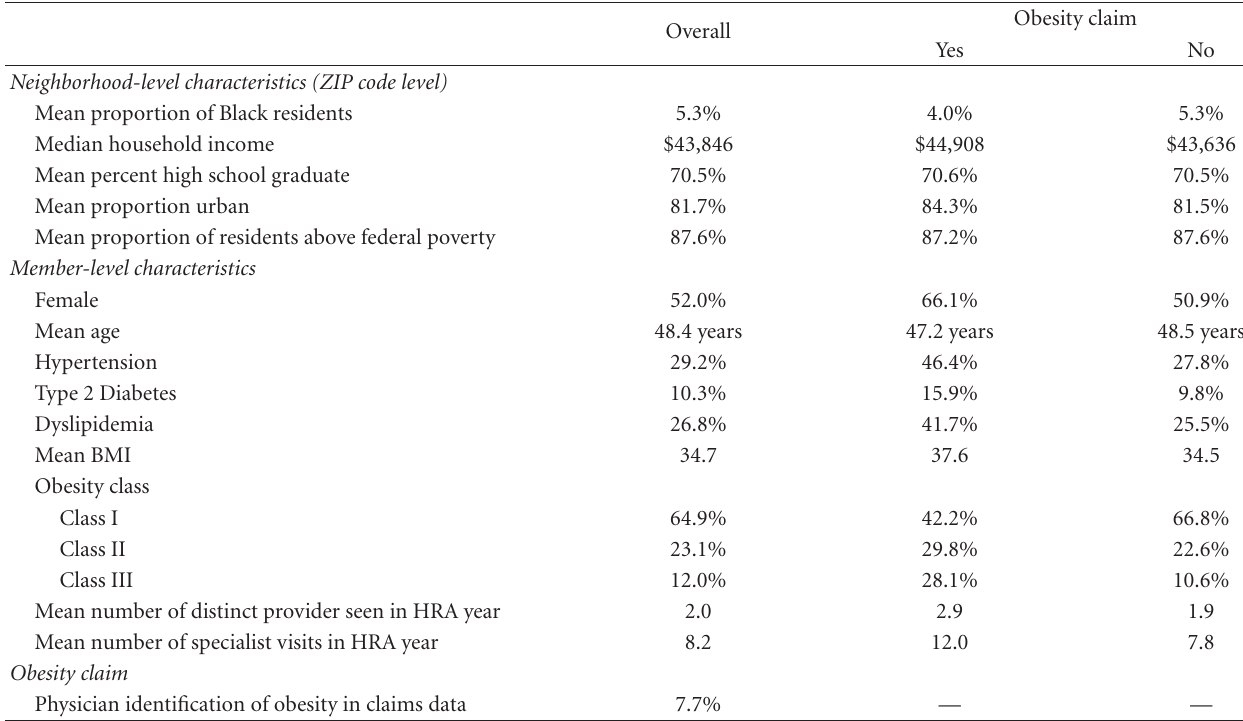
Table 1: Characteristics of the study sample ( N =